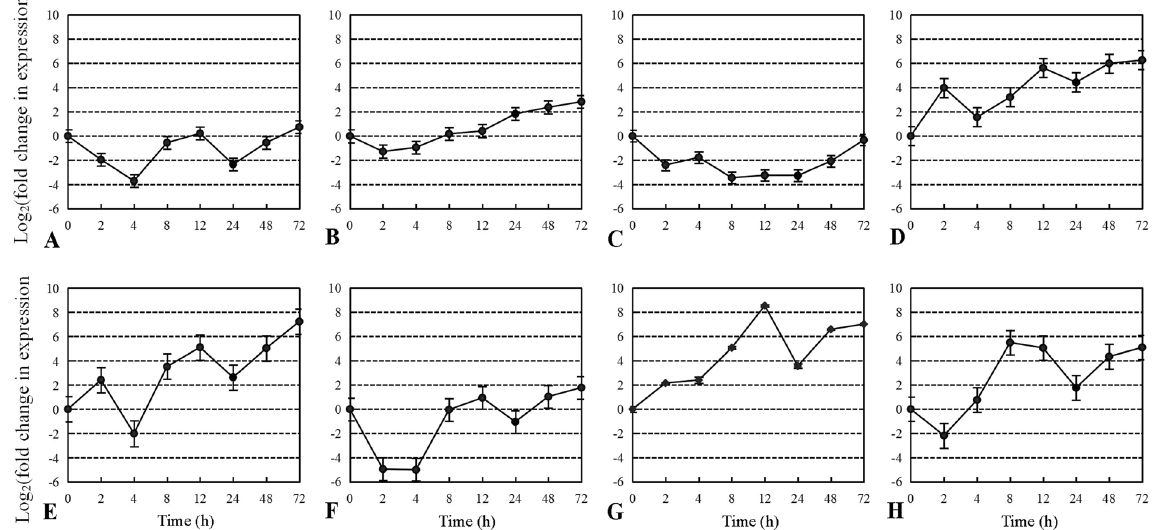
Figure 2. Differential expression of Epl1-Tas in T . asperellum ACCC30536 under eight inducing conditions. X-axis: time points, Y-axis: expression level = Log 2 (fold change in expression), namely expression of Epl1-Tas under minimal medium (MM) conditions ( A ), C starvation conditions ( B ), N starvation conditions ( C ), 1% mycelia powder of A . alternata grown in 1/4PD for 10 d ( D ), 5% fermentation liquid of A . alternata grown in 1/4PD for 10 d ( E ), 1% root powder of Populus davidiana × P . alba var. pyramidalis (PdPap) seedlings ( F ), 1% stem powder of PdPap seedlings ( G ), and 1% leaf powder of PdPap seedlings ( H ). All experiments were performed three times. The quantitative data are presented in Supplementary Table